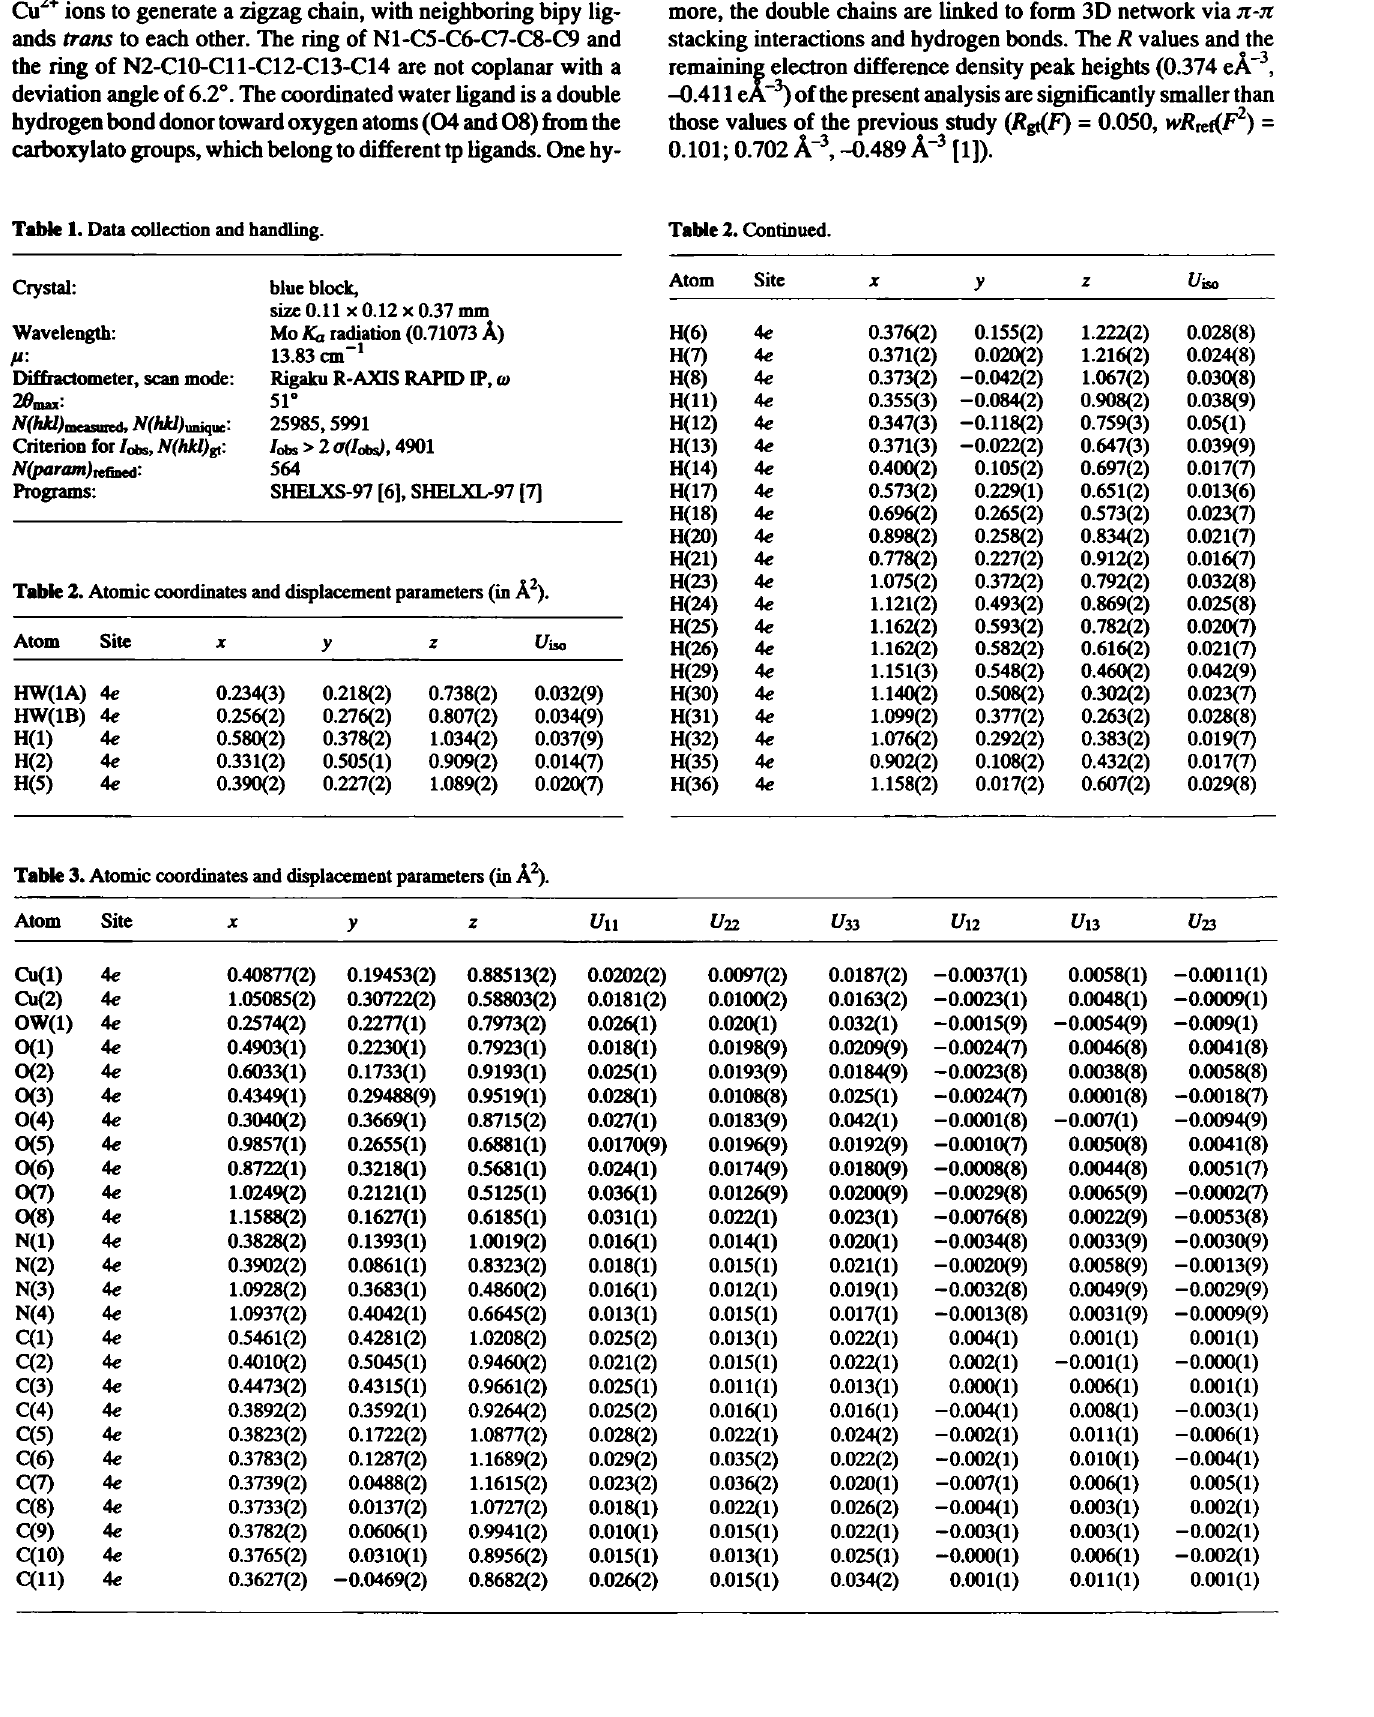
Table 2. Atomic coordinates and displacement parameters (in Ä 2 ).